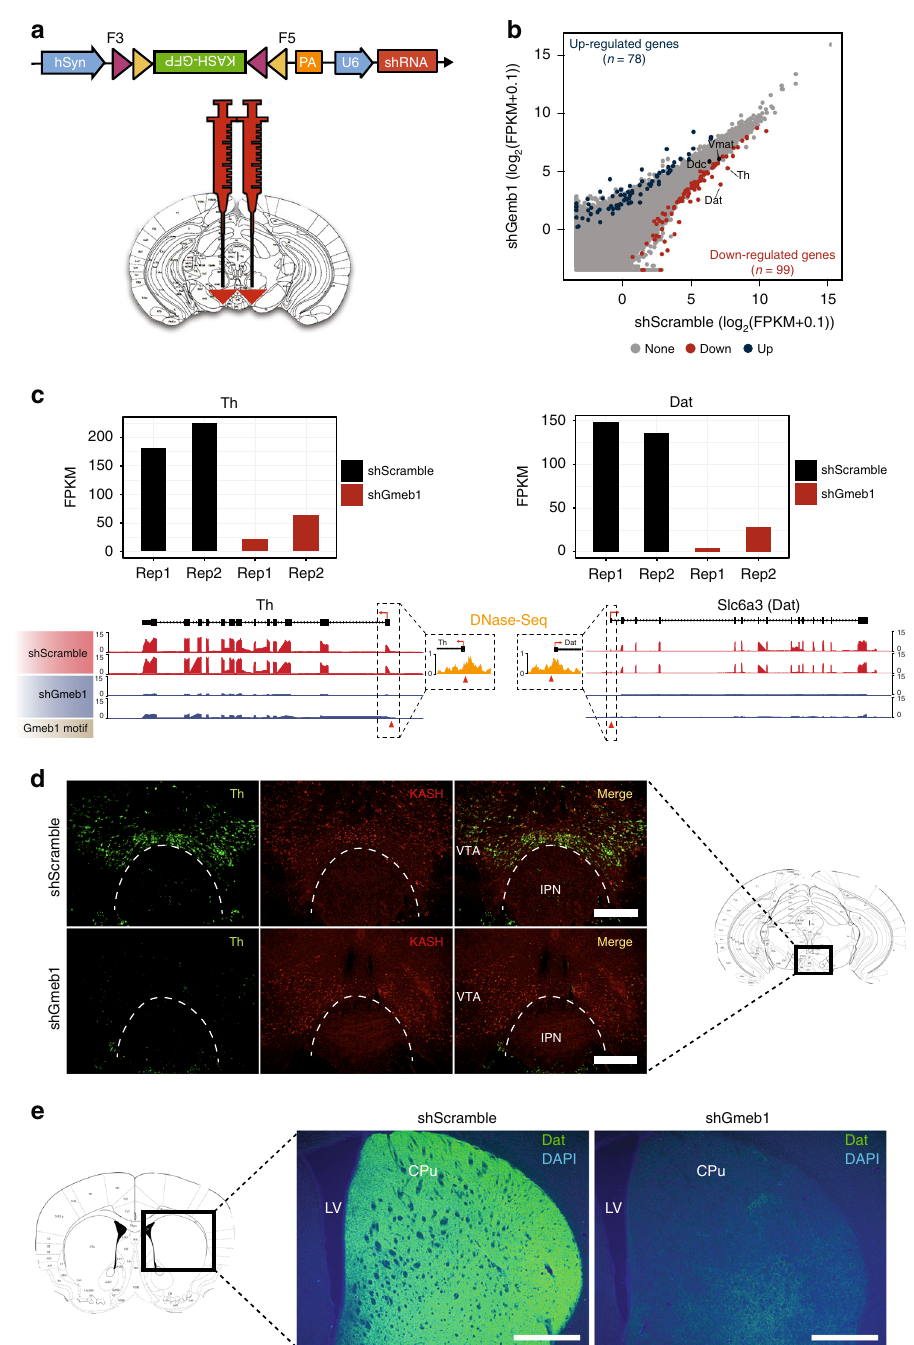
Fig. 3 Midbrain Gmeb1 knockdown results in loss of Th and Dat. a Diagram of the DIO-KASH-GFP-shRNA expressing vector (top) and location of midbrain virus injection in Dat-Cre mice (bottom). b Scatter plot comparing RNA-Seq data of mDA neurons of control (shScramble, n = 2) and Gmeb1 knockdown (shGmeb1, n = 2). Gmeb1 knockdown results in down-regulation of 99 genes (blue), including Th and Dat , and up-regulation of 78 genes (red) (fold change > 2; p-value < 0.05). c Histograms (RPKM) and genome browser view showing down-regulation of Th and Dat following Gmeb1 knockdown. Dashed inserts: Location of Gmeb1 motifs in promoter DHS for Th and Dat (red triangles). d Representative immunostaining pictures showing KASH-HA tagged mDA nuclei (red) and reduction of Th (green) in VTA of shGmeb1-treated mice. Box inserts re fl ect brain region where micrograph was obtained. Scale bar: 500 μ m. Note: Coronal brain section was reproduced from ref. 48 . (Copyright 2013, Elsevier, Academic Press). e Representative immunostaining pictures showing reduction of Dat (green) in caudate putamen (CPu) of shGmeb1-treated mice. LV; Lateral ventricle. Box inserts re fl ect brain region where micrograph was obtained. Scale bar: 500 μ m. Note: Coronal brain section was reproduced from ref. 48 . (Copyright 2013, Elsevier, Academic